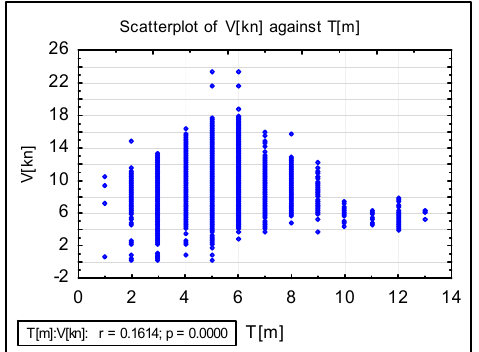
Figure 7. The scatterplot of vessel speed against draught.